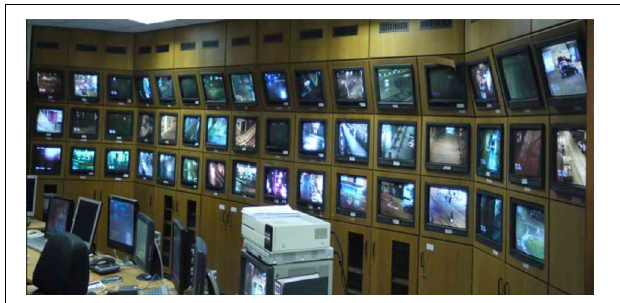
FIGURE 3 | Examples of eye gaze videos with gaze position crosshair